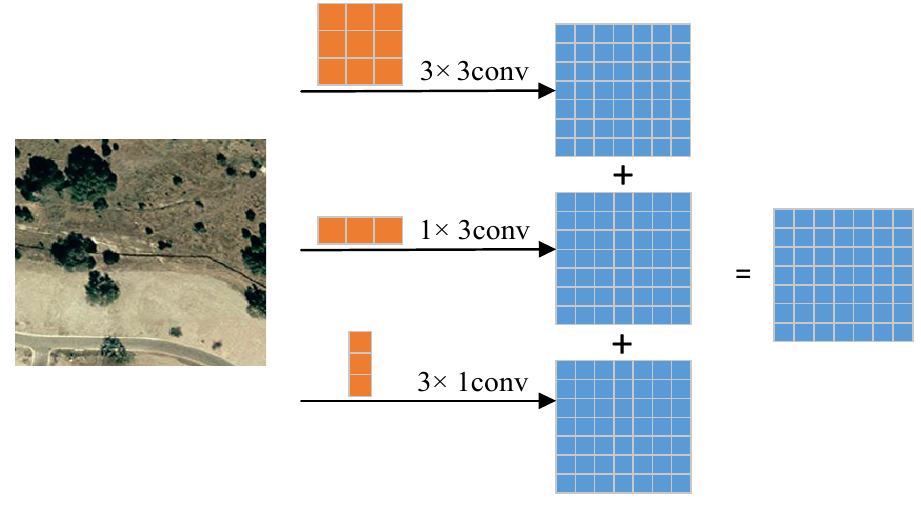
Figure 6. The structure of ACB.